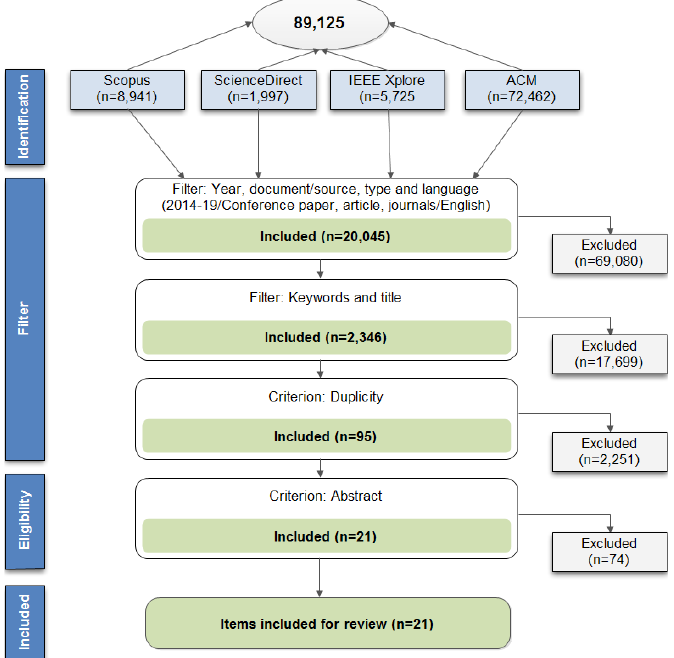
Figure 3. Systematic literature-review (SLR) selection